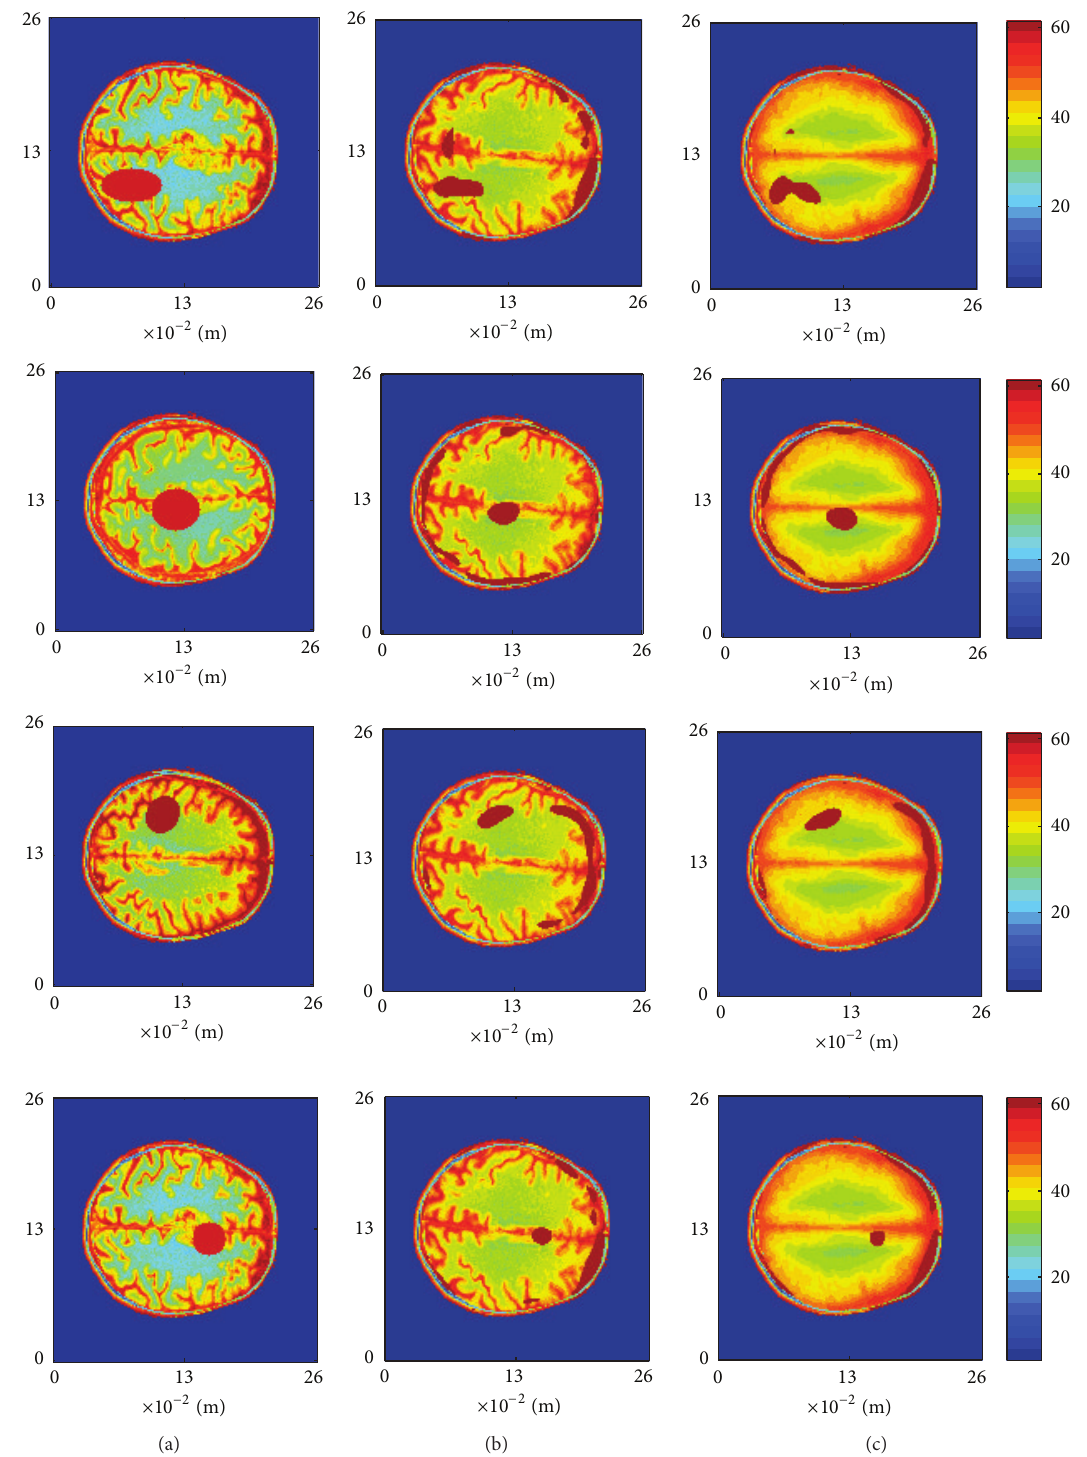
Figure 4: Reconstruction for different stroke locations and sizes, using RM (central column) and AMM (right column) initial guesses. The left column shows the patient’s brain